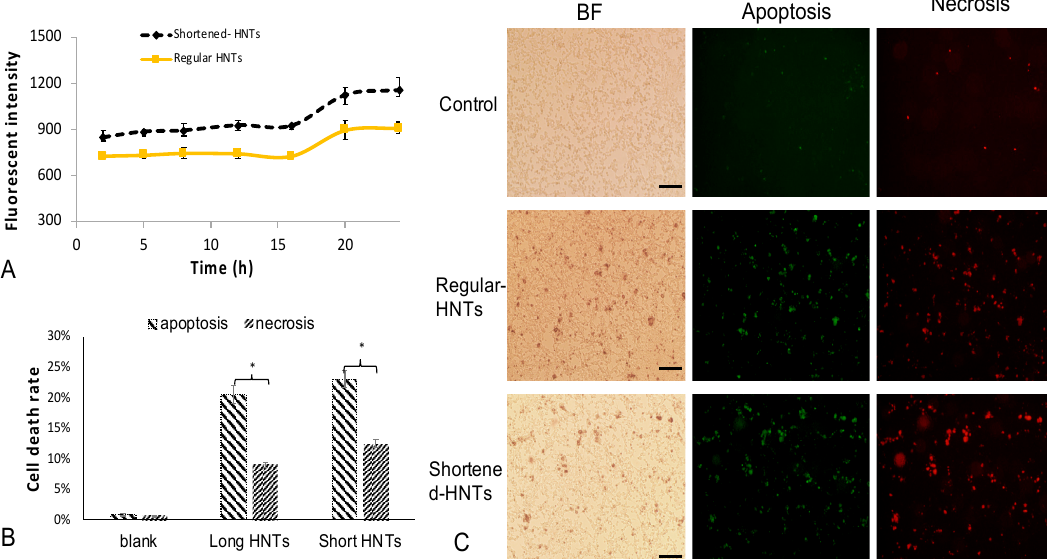
Figure 5. ( A ). Fluorescent intensity of FITC detected from CT26WT cells after 24 h incubation time (cell number for each test = 4.46 × 10 5 ± 0.063 × 10 5 , each group had 9 tests, error bar with standard deviation). ( B ). The summary of flow cytometry results for apoptosis and necrosis analysis. The detailed flow cytometry results showed in Supplementary Information Figure S1. (cell number for each test = 3 × 10 5 , each group had 6 tests, error bar with standard deviation, * represents p < 0.05) ( C ). Fluorescent pictures for apoptosis & necrosis analysis, the green color represents apoptosis and the red color represents necrosis. The first column represents brightfield images (scale bar with 100 μ m).